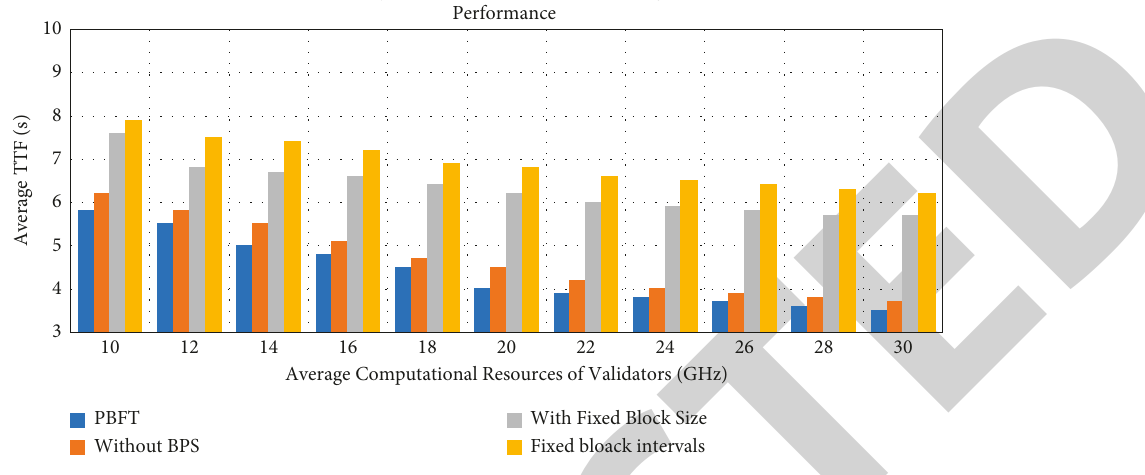
Figure 9: PBFT performance in terms of latency and average computational